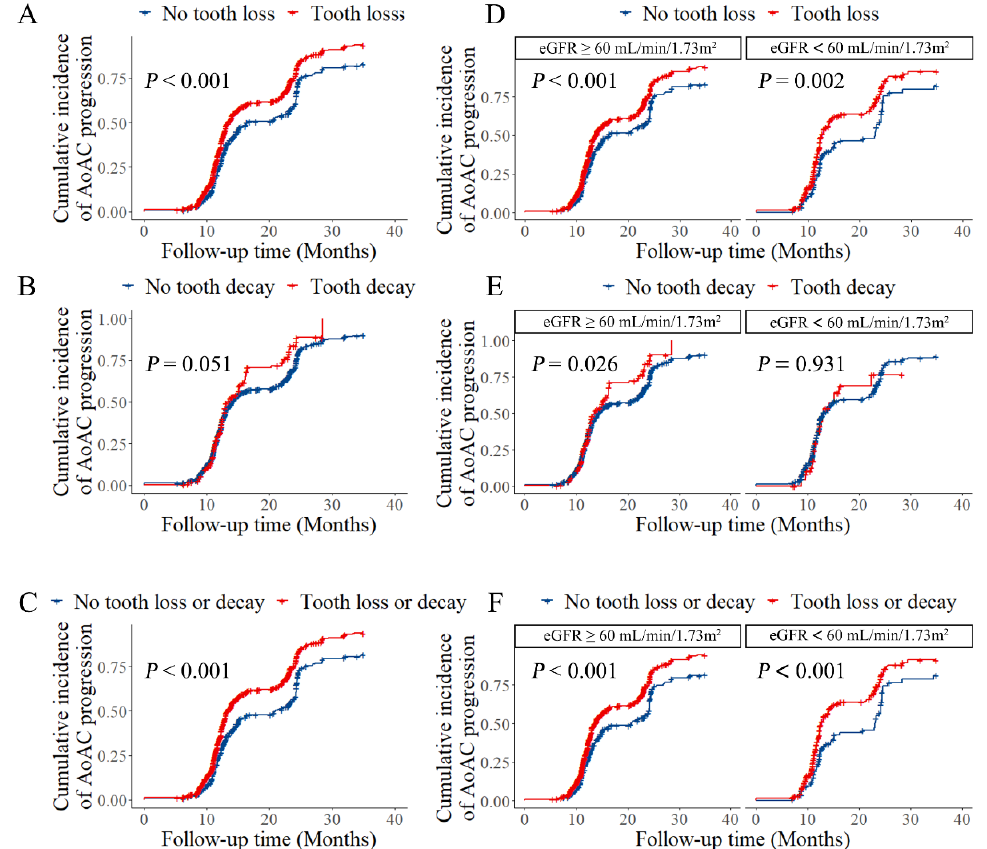
Figure 3. Cumulative incidences of AoAC progression by dental diseases and stratified by renal dysfunction. ( A – C ) show cumulative incidences of AoAC progression by tooth loss, tooth decay, tooth loss, or decay, respectively, and ( D – F ) show results stratified by renal dysfunction. The cumulative incidences were estimated with the Kaplan–Meier method and compared with the log-rank test.